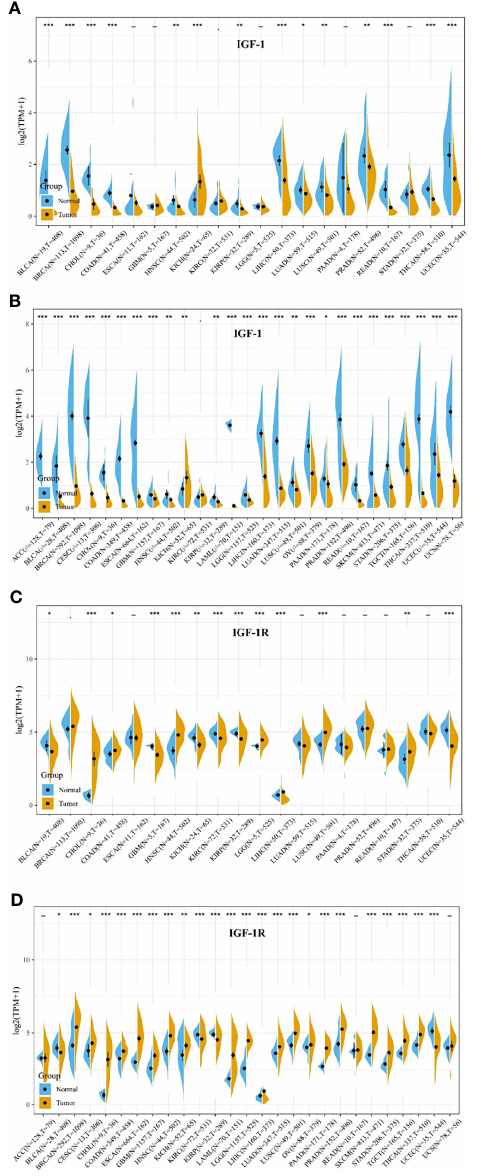
associations were BLCA ( Figure 4A ), BRCA ( Figure 4B ), and CHOL ( Figure 4C ). While for IGF-1R, three of the most signi fi cant associations were BLCA ( Figure 4D ), LIHC ( Figure 4E ), and PRAD ( Figure 4F ). TIMER showed that both